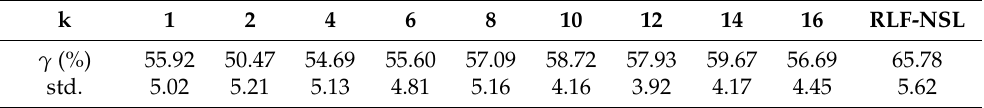
Table A3. The classification accuracy γ and the standard deviation (std.) on the IMDb dataset for N = 100 by KNN with different k and by the RLF-NSL with β = 1.06.